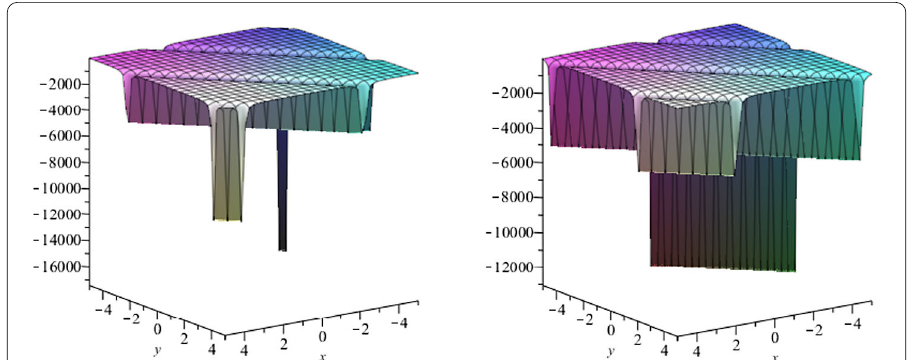
Figure 4 Periodic wave solution of Eq. (4.31) with β = 0.25 and β = 0.9, respectively, when λ = 1